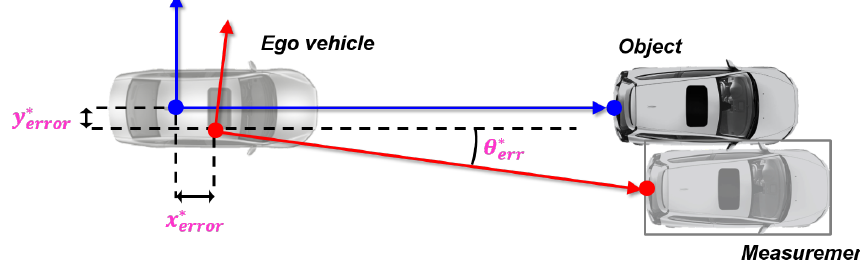
Figure 8. Parameters of sensor position error